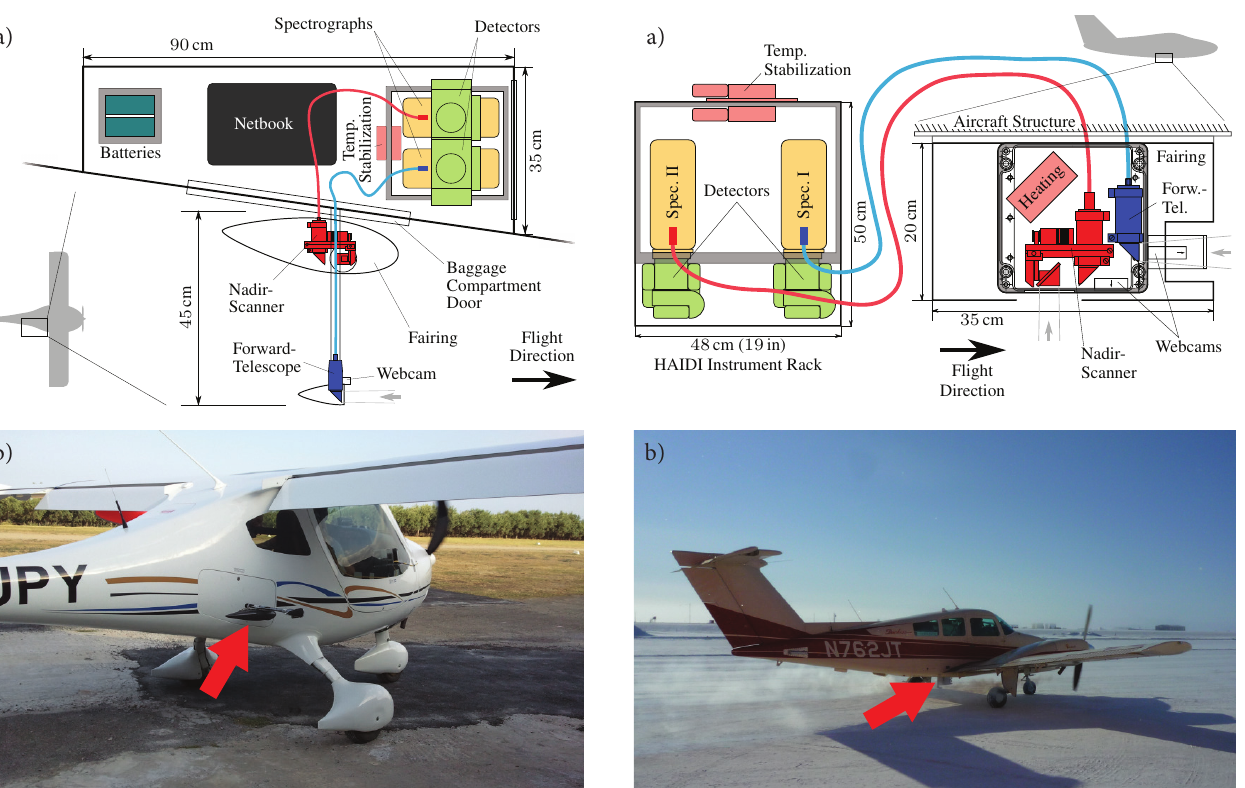
Figure 17. Instrumental setup for measurement flights with the ALAR research aircraft from Purdue University. (a) Sketch showing HAIDI’s instrument rack and the aluminum box with the entrance optics. Each viewing direction is equipped with additional webcams to record weather and surface conditions. (b) ALAR research air- craft with HAIDI installed. The red arrow is pointing to the box with the entrance optics of the instrument, which is connected to the spectrographs and detectors inside the aircraft via fiber optic cables going through the fuselage of the